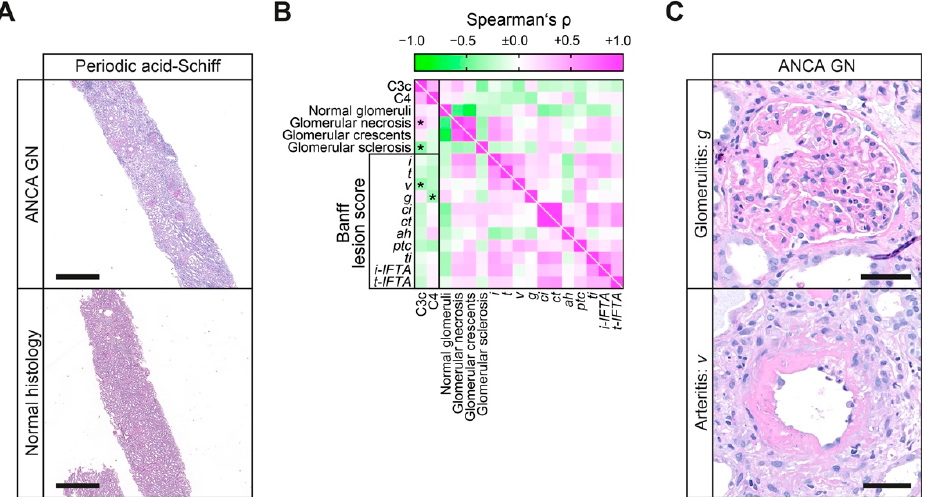
Figure 4. Low levels of circulating C3c and C4 indicate vasculitis manifestations to distinct renal compartments in ANCA GN. ( A ) Representative periodic acid-Schiff-stained kidney section of ANCA GN (scale bar: 1 mm). ( B ) Circulating levels of C3c and C4 in association with glomerular and tubulointerstitial lesions (analogous to the Banff scoring system) are shown by heatmap reflecting mean values of Spearman’s ρ , asterisks indicate p < 0.05. ( C ) Representative periodic acid-Schiff-stained kidney section with glomerulitis: g and arteritis: v lesions in ANCA GN (analogous to the Banff scoring system, scale bars: 50 µ m). Abbreviations: ah , arteriolar hyalinosis; ANCA, anti-neutrophil cytoplasmic antibodies; C3c, complement factor 3 conversion product; C4, complement factor 4; ci , interstitial fibrosis; ct , tubular atrophy; g , glomerulitis; GN, glomerulonephritis; i , interstitial inflam- mation; i-IFTA , inflammation in IFTA; t , tubulitis; ptc , peritubular capillaritis; ti , total inflammation; t-IFTA , tubulitis in IFTA; v , intimal Table 6. Multiple regression analysis for variables associated with circulating C3c.